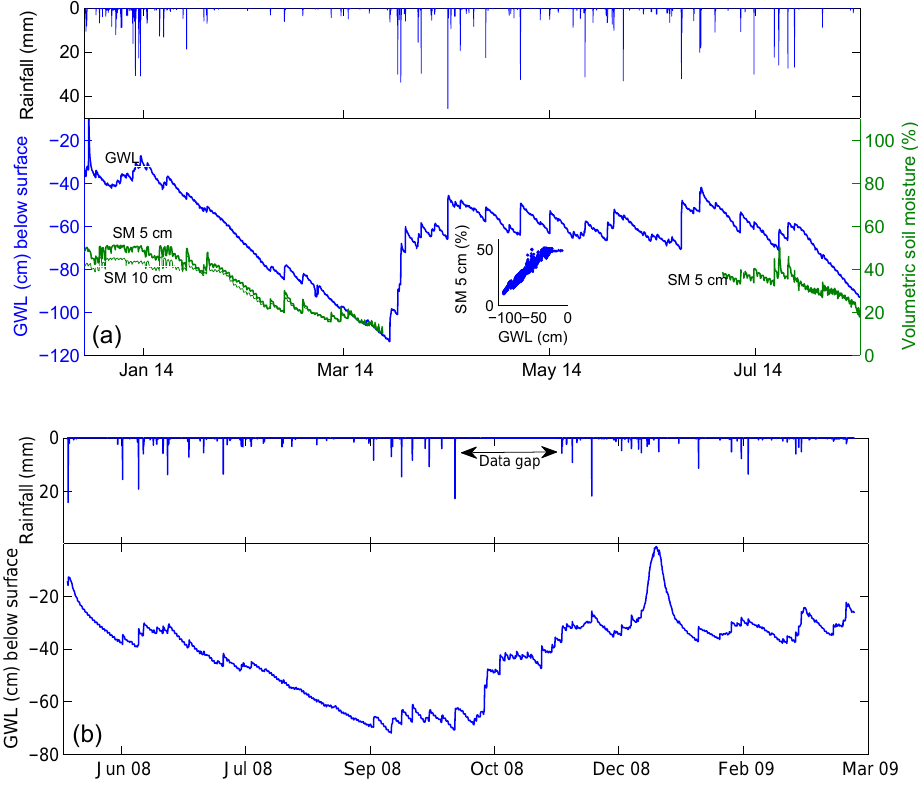
Figure 8. (a) Hourly groundwater level and surface level (5cm deep) and 10cm-deep soil moisture response as results of rainfall (and no rainfall) events in the Kapuas. The scatter plot shows the relation between soil moisture and groundwater level. Note that while rainfall and soil moisture were measured at the same location (mineral soil), groundwater level was measured about 5km apart (peat soil). (b) Hourly rainfall and groundwater level of the Mahakam peat forest near Lake Melintang.